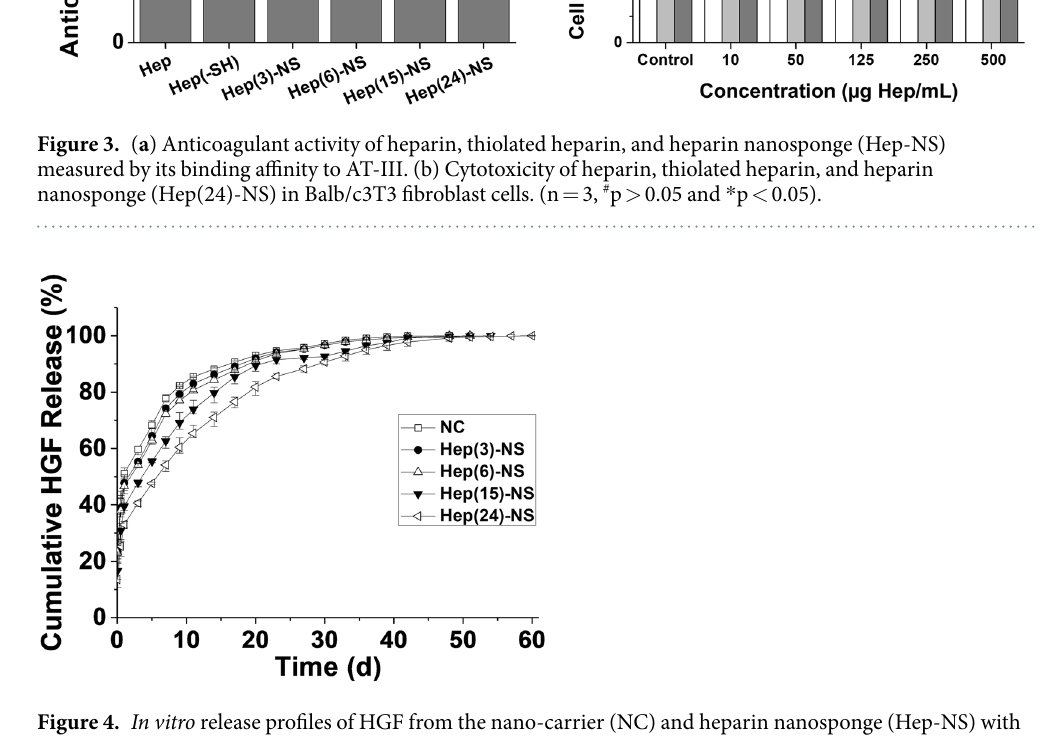
Figure 4. In vitro release profiles of HGF from the nano-carrier (NC) and heparin nanosponge (Hep-NS) with various amounts of